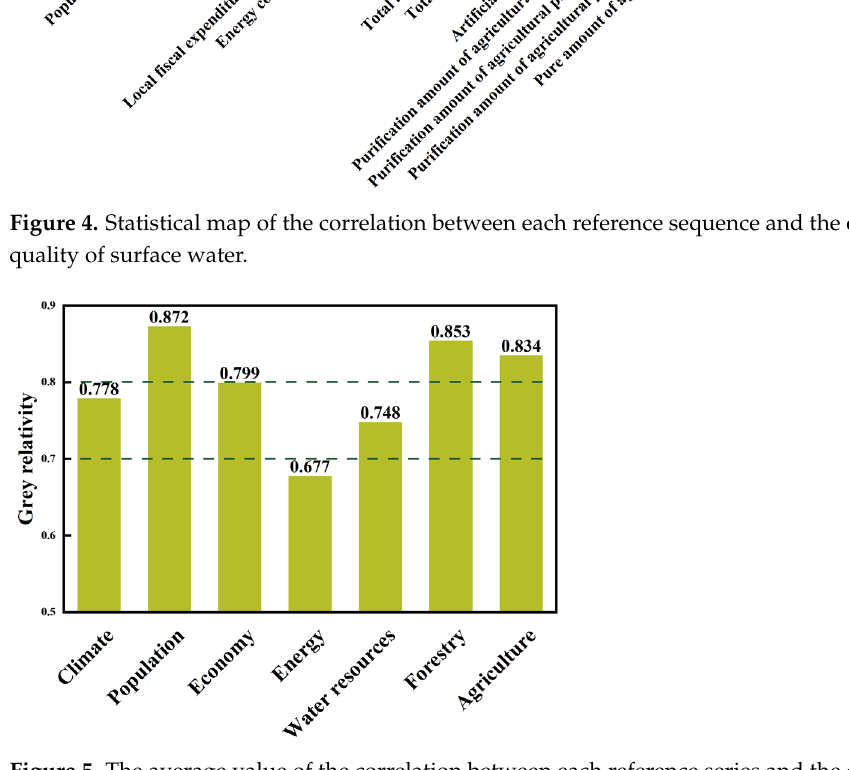
Figure 5. The average value of the correlation between each reference series and the environmental quality of surface water.